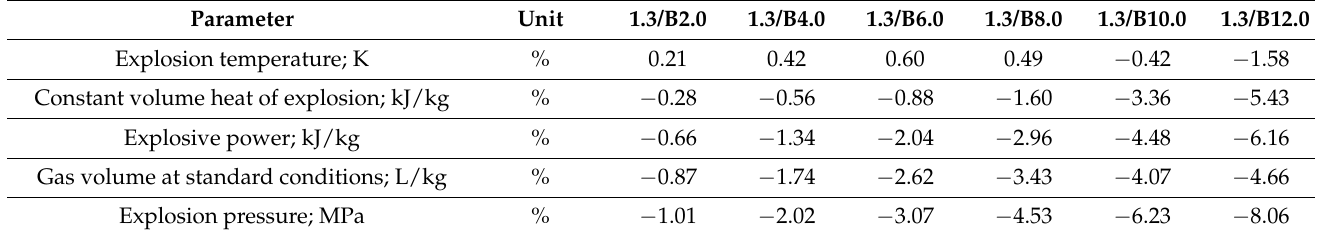
Table 5. Percentage change in the values of individual parameters for EX from variant 1.3 compared to